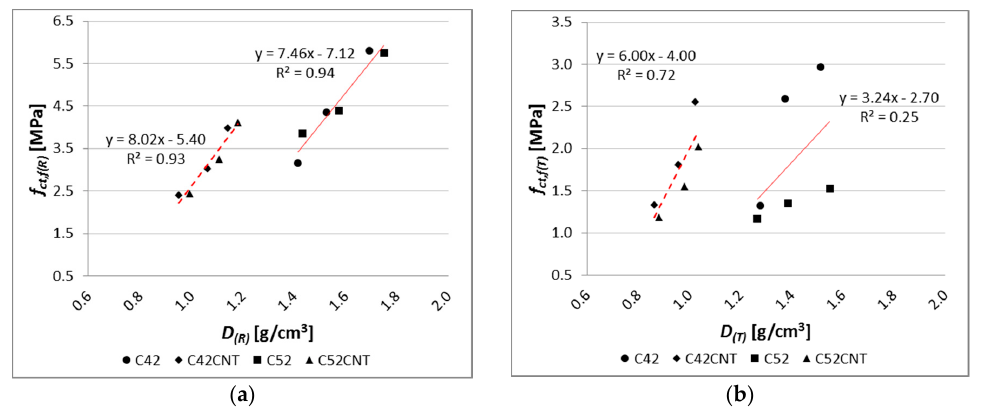
Figure 16. Relationship between bending tensile strength and apparent density of tested materials for ( a ) reference samples; ( b ) samples after thermal load.